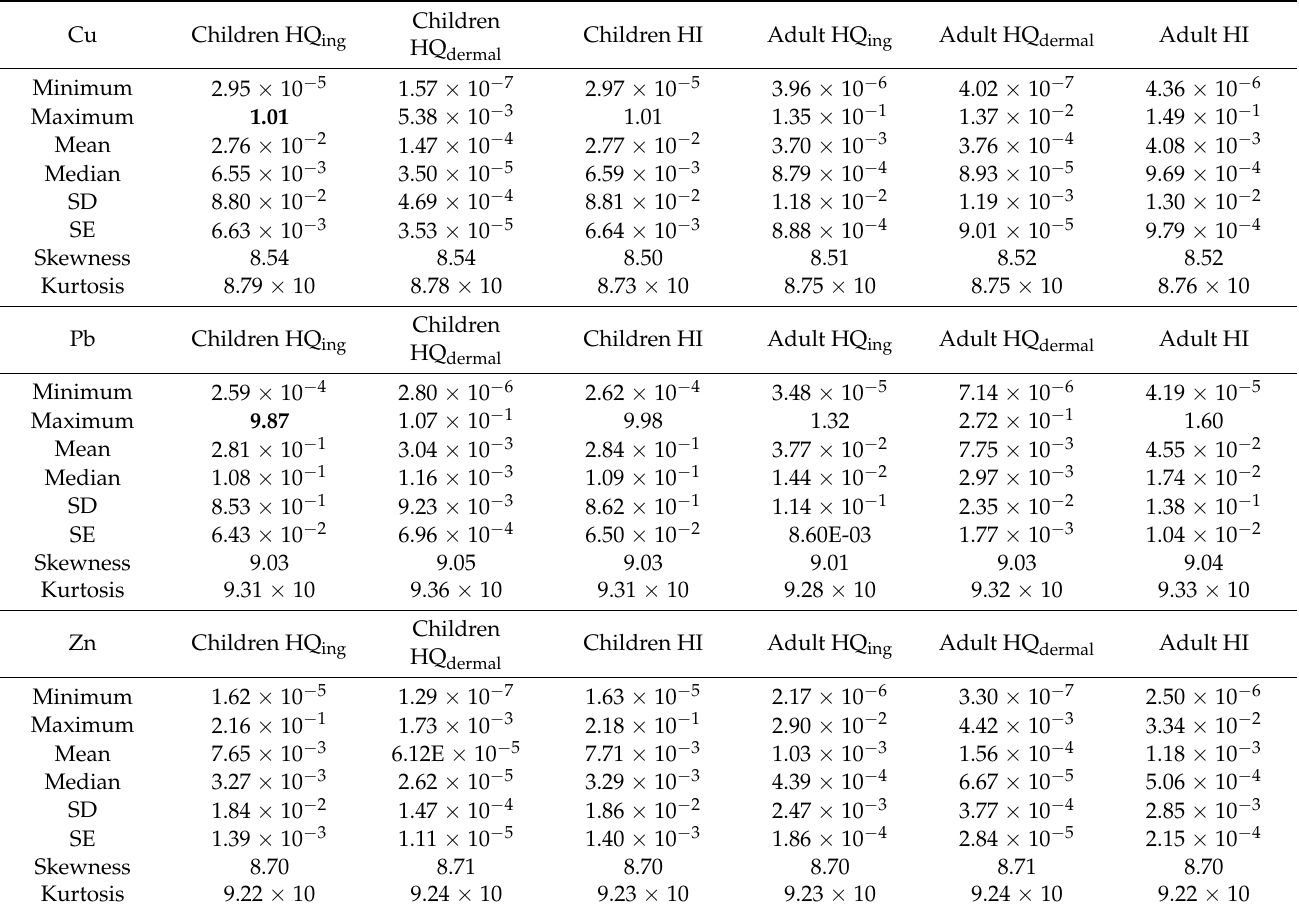
Table 5. Overall statistics of values of hazard quotient ingestion (HQ ing ), hazard quotient dermal (HQ dermal ), and hazard index (HI) of Cu, Pb, and Zn for children and adults from ASEAN-5 (N = 176) were obtained in the present